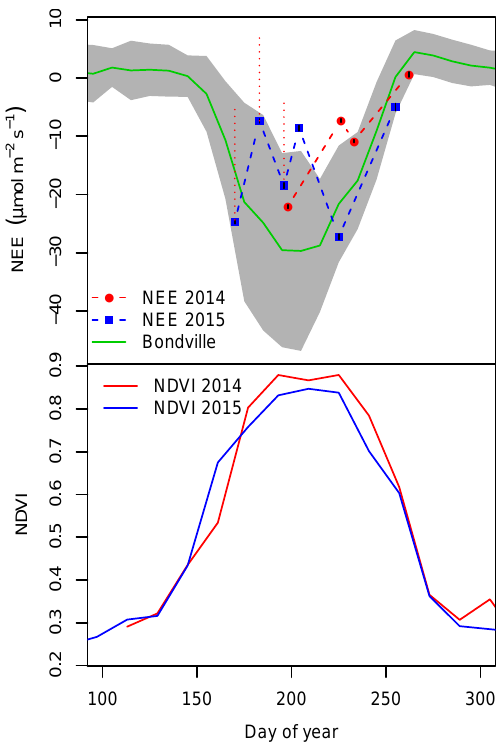
Figure 5. Seasonal patterns in NDVI (bottom panel) and NEE (top panel) for 2014 and 2015 and data from the Bondville eddy flux site for 1996 to 2008. NEE data in the top panel include the NEE HAB estimates (dashed lines and filled circles (2014) and squares (2015)) and 10-day averages of midday (11:00–15:00 local standard time) NEE for Bondville (green solid line). The gray shaded region indi- cates 1 standard deviation above and below the mean for Bondville. The vertical black lines are ± 1 standard error for the HAB NEE esti- mates. The vertical red dotted lines show the instrument adjustment that was necessary for three of the flights. HAB-based NEE falls within or very close to the shaded region. NDVI generally tracks NEE well, but NEE from both Bondville and the HAB technique approaches zero sooner than NDVI in the